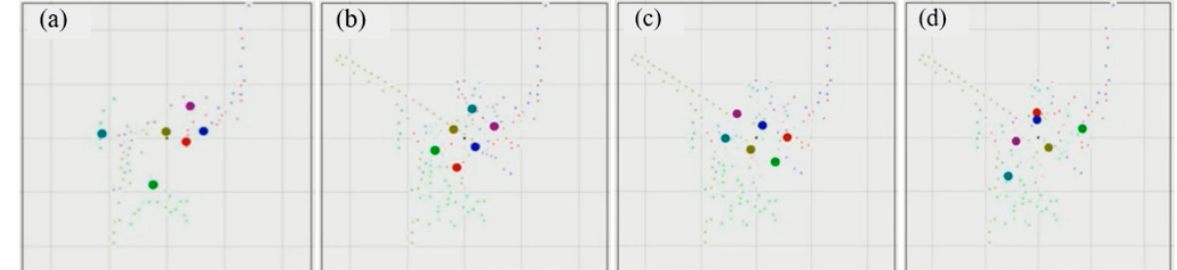
Figure 7. Results of laboratory testing the RTK rovers before placement on animals. Each figure shows the measured location of six rovers that were rigidly fixed on a 1 m × 2 m grid. ( a ) Before RTK fix was achieved and showing differential GNSS accuracy. ( b ) Rovers stationary with a clear view of the sky. ( c ) Rovers moving with a clear view of the sky. ( d ) Rovers moving underneath tree foliage and losing view of GNSS satellites and during the walk behind the trees which led to blocking of the satellite signals and the RTK correction link (heading NE). Note: The grid size is 2 m and the centre of the plot tracks to the centre of the array of RTK rovers. The large dots indicate the current location of the RTK rovers with the smaller dots displaying their movement history. Plots b and c show the situations similar to that expected in the real trial in the field.